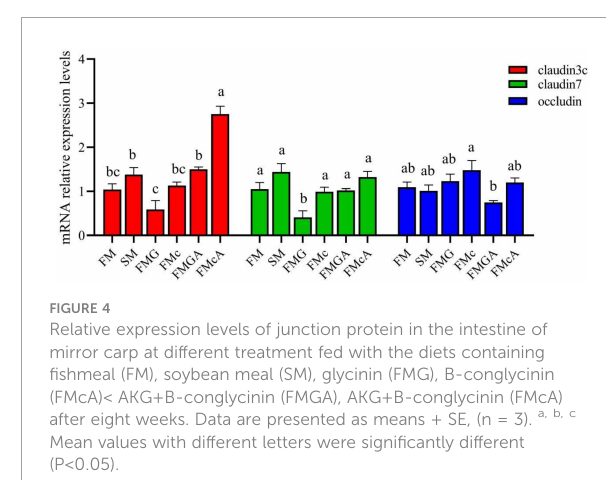
FIGURE 4 Relative expression levels of junction protein in the intestine of mirror carp at different treatment fed with the diets containing fi shmeal (FM), soybean meal (SM), glycinin (FMG), B-conglycinin (FMcA)< AKG+B-conglycinin (FMGA), AKG+B-conglycinin (FMcA) after eight weeks. Data are presented as means + SE, (n = 3). a, b, c Mean values with different letters were signi fi cantly different